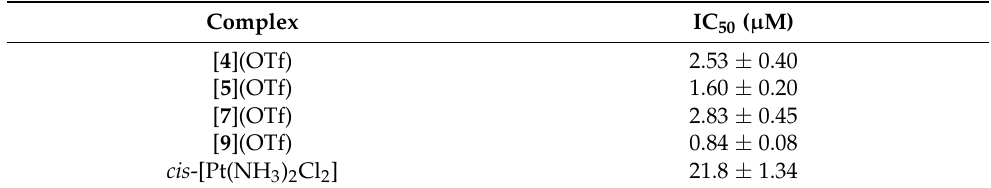
Table 1. Cytotoxicity (IC 50 , µ M) of complexes [ 4 ](OTf), [ 5 ](OTf), [ 7 ](OTf), [ 9 ](OTf) and cis